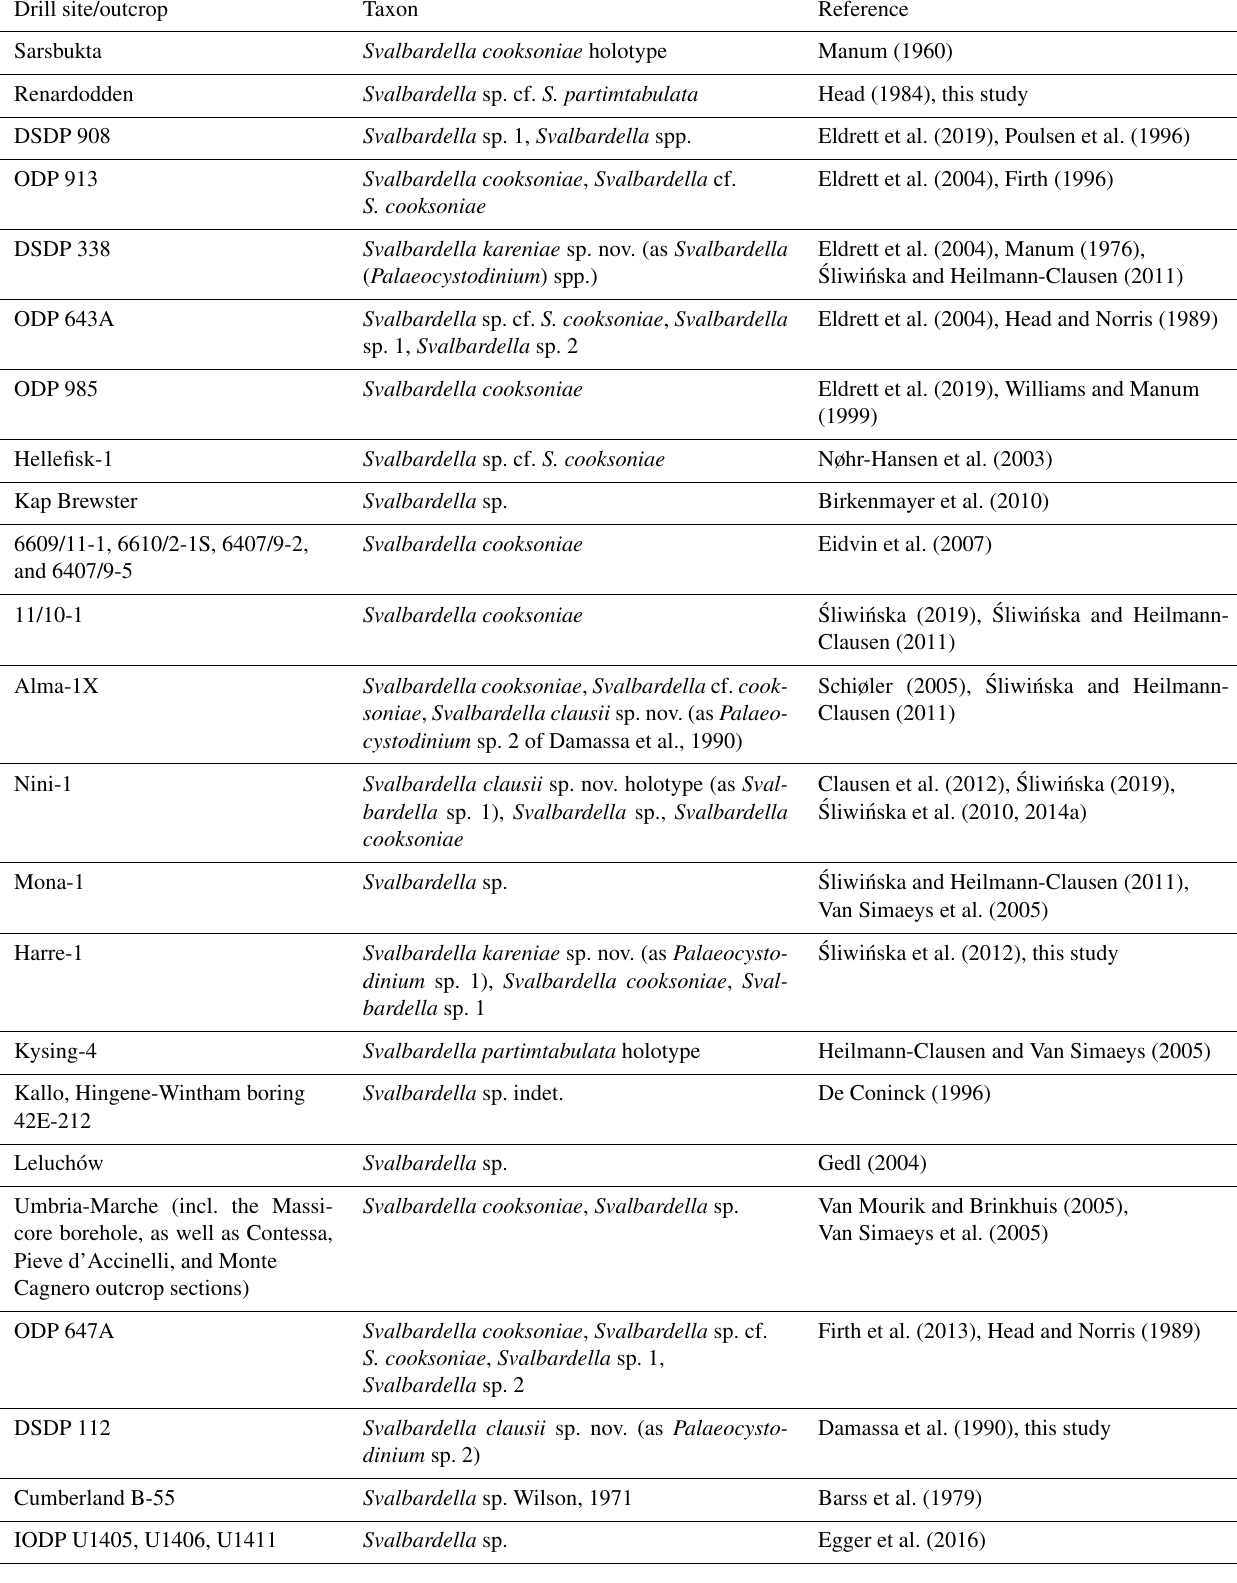
Table 1. Drill sites and outcrops yielding specimens here attributed to the genus Svalbardella from the North Atlantic–Arctic region illus- trated in Fig.